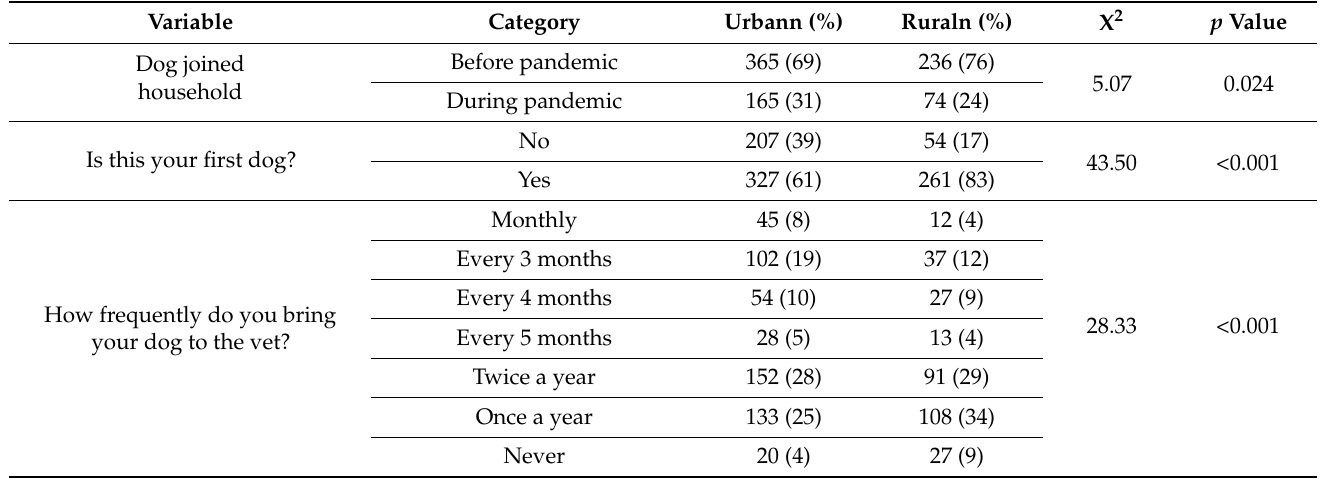
Table 3. Chi-squared (X 2 ) analysis for factors significantly associated ( p < 0.05) with dogs in urban or rural